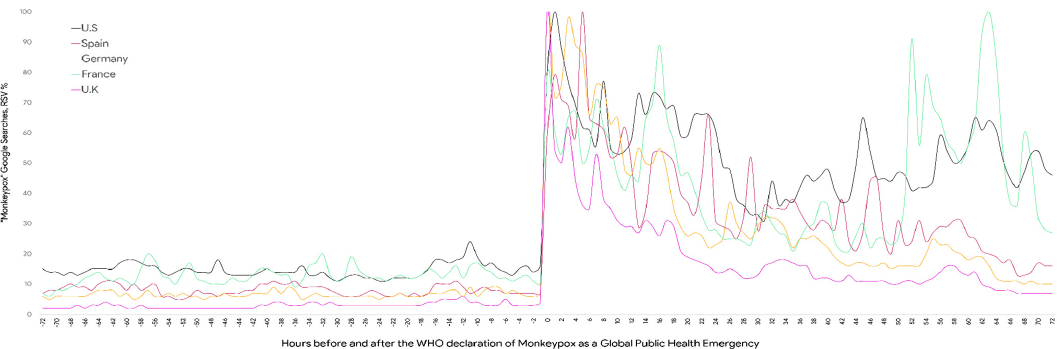
Figure 3. Monkeypox online real ‐ time hourly searches before and just after the WHO declaration of Monkeypox outbreak as a Public Health Emergency of International Concern (PHEIC) .